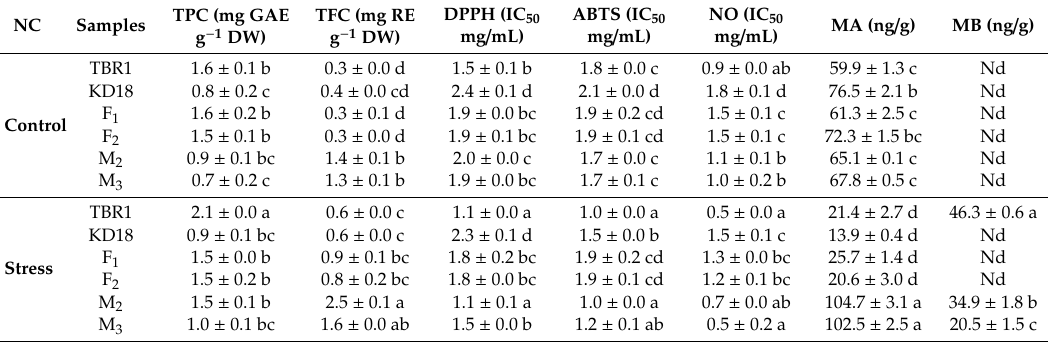
Table 2. Changes in phytochemical properties of examined rice in salt stress.